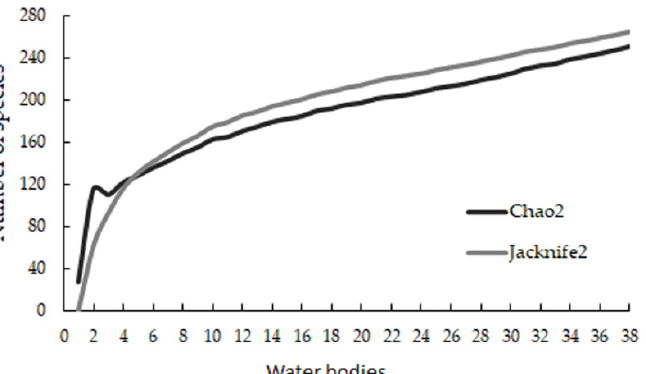
Figure 3. Estimation of diversity of rotifers in Greek waterbodies using the estimators Chao2 and Jackknife2.